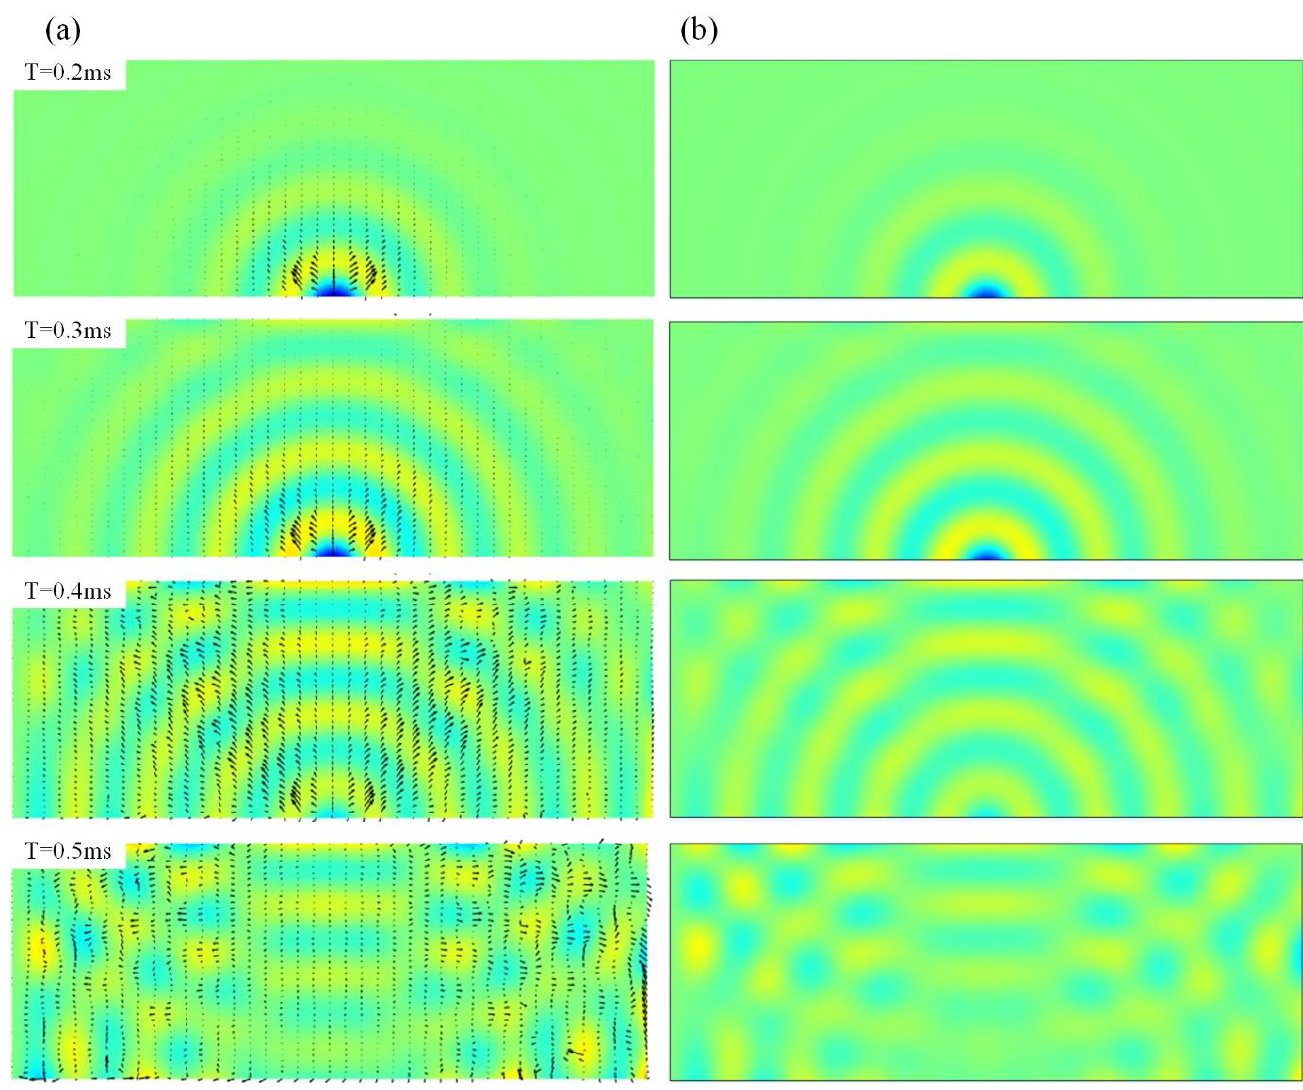
Figure 3. The full-field displacement response within 0.2 to 0.5 ms of the intact plate ( a ) the semi- analytical method with the power transmission paths. ( b ) The FEM methods.